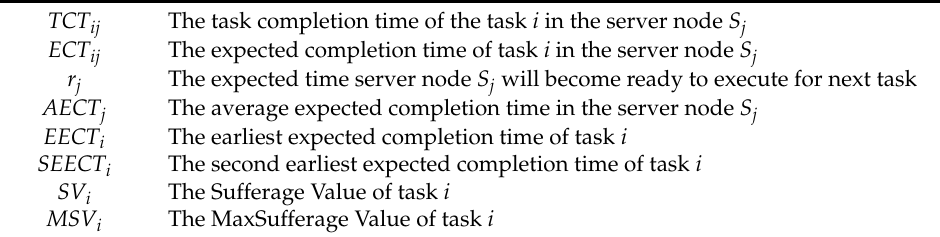
Table 3. The notations of ACSS algorithm in the server nodes selection